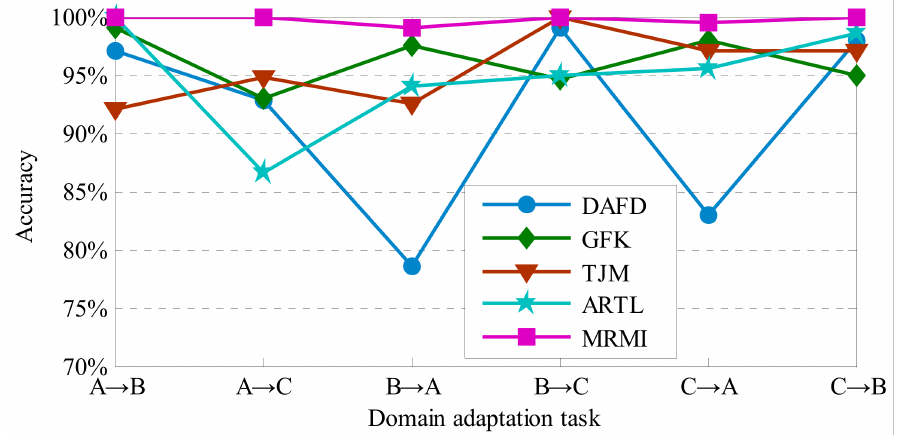
Figure 8. The diagnosis results for sample class imbalanced gear